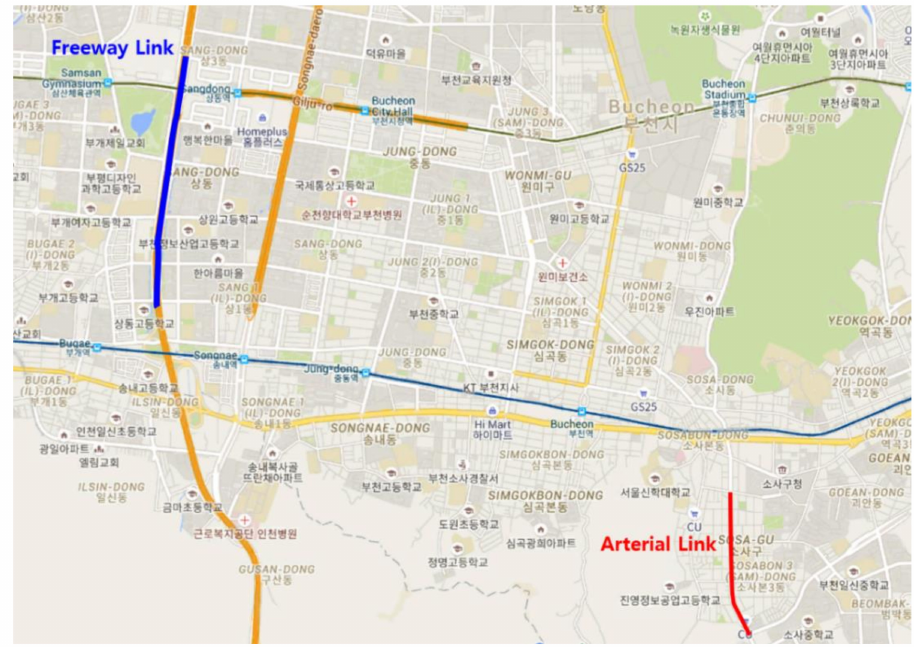
Figure 2. Study Area. (Map source: Google